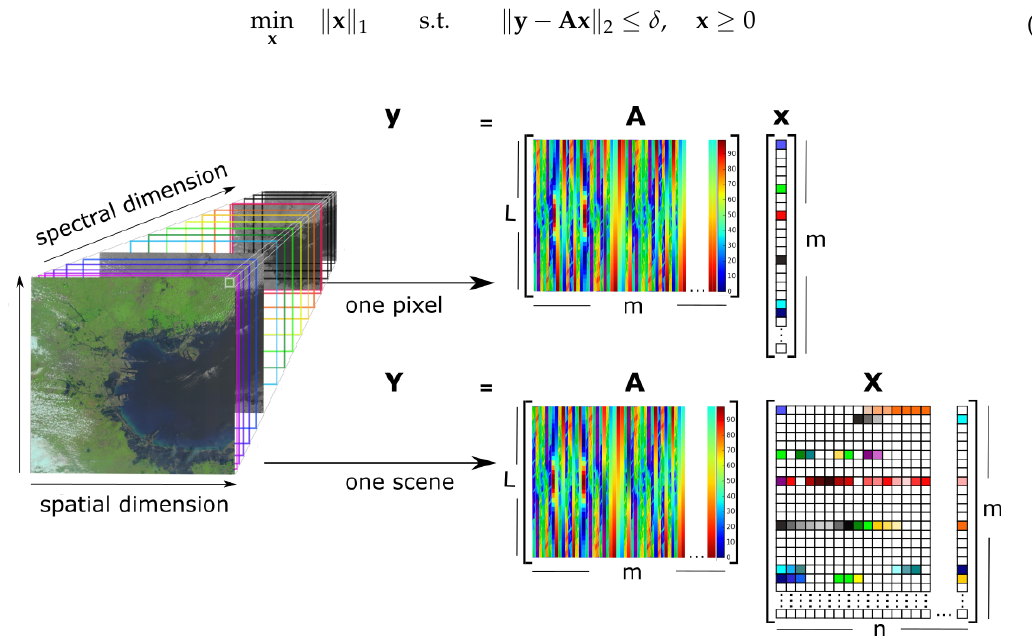
Figure 1. Illustration of hyperspectral image and sparse unmixing for pixel ( top ) and image ( bottom